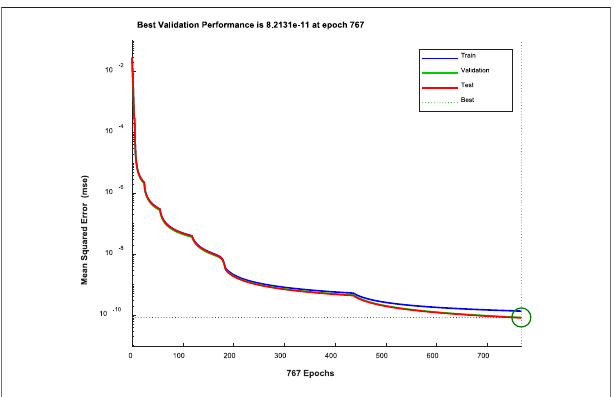
FIGURE 10 | The training result of the NN.